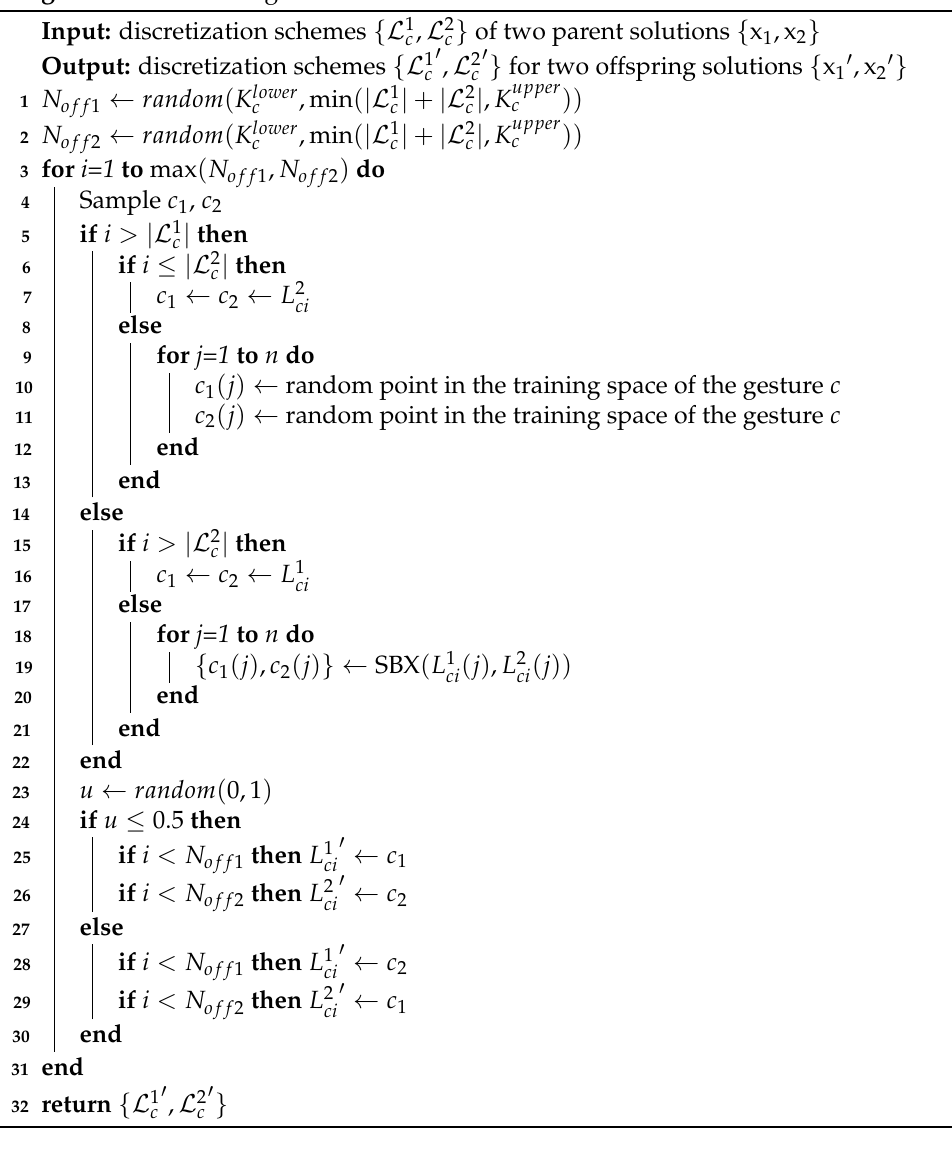
Algorithm 1: Rand-length crossover for discretization